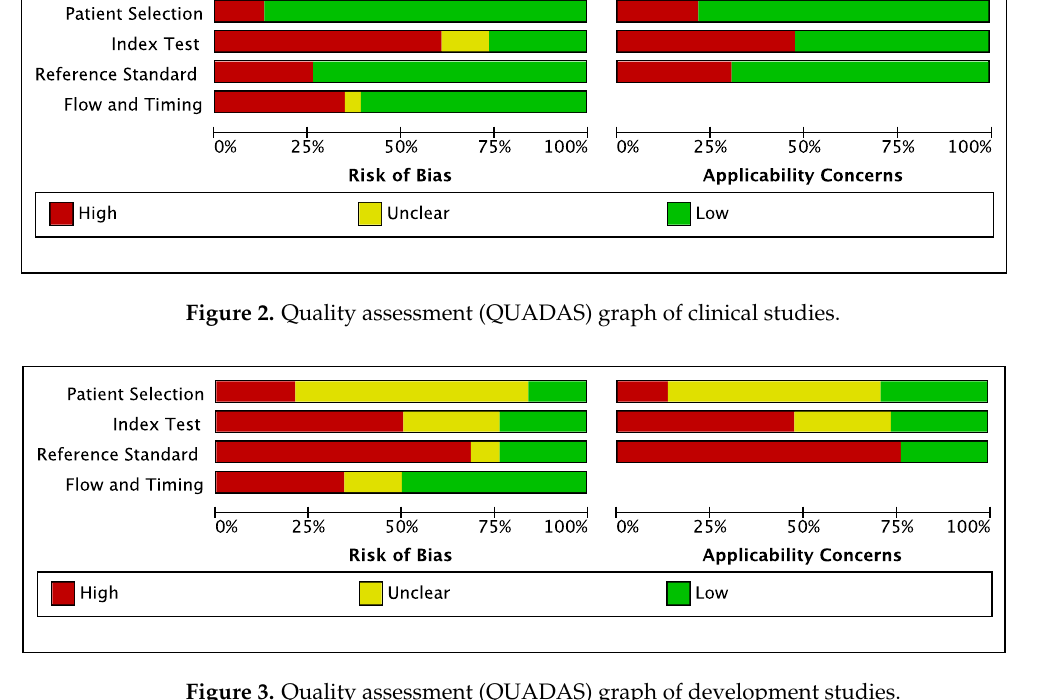
Figure 3. Quality assessment (QUADAS) graph of development studies.